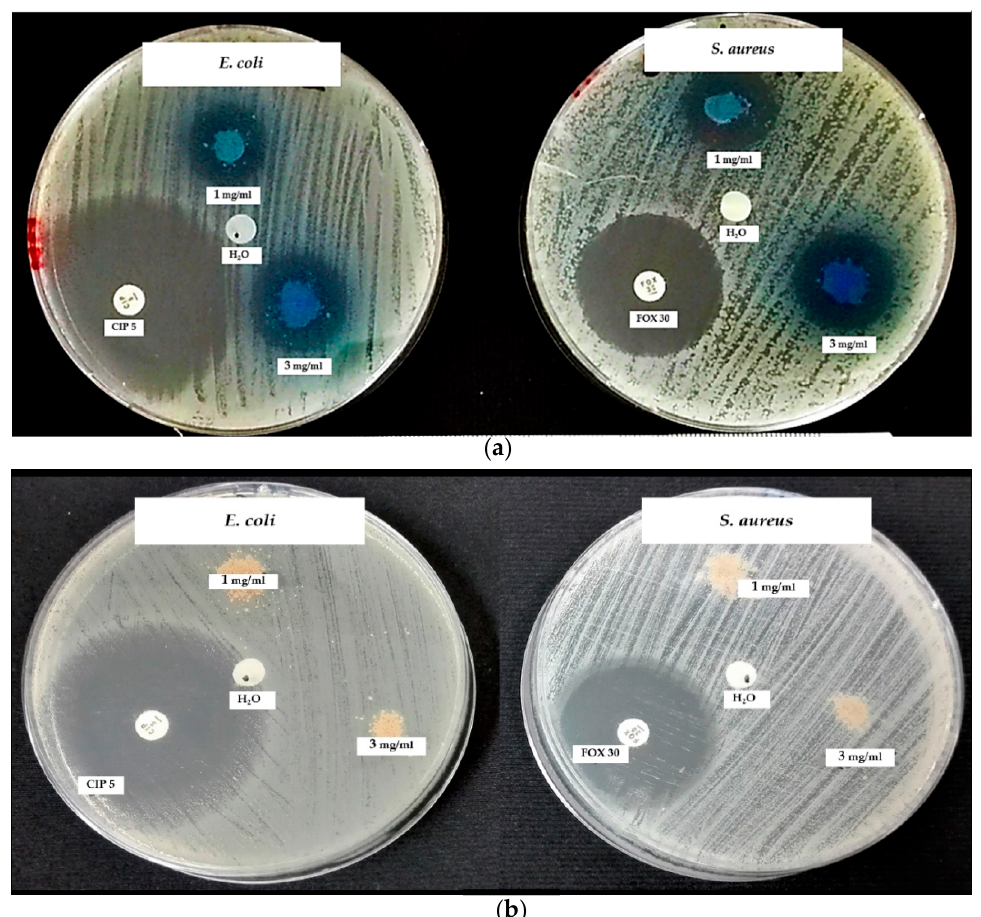
Figure 7. Disc di ff usion assay against E. coli and S. aureus . ( a ) Using 1 and 3 mg / mL of nZH-Cu as an Figure 7. Disc diffusion assay against E. coli and S. aureus . ( a ) Using 1 and 3 mg/mL of nZH-Cu as an antimicrobial agent. ( b ) Using 1 and 3 mg / mL of nZH, n = antimicrobial agent. ( b ) Using 1 and 3 mg/mL of nZH, n = 3.